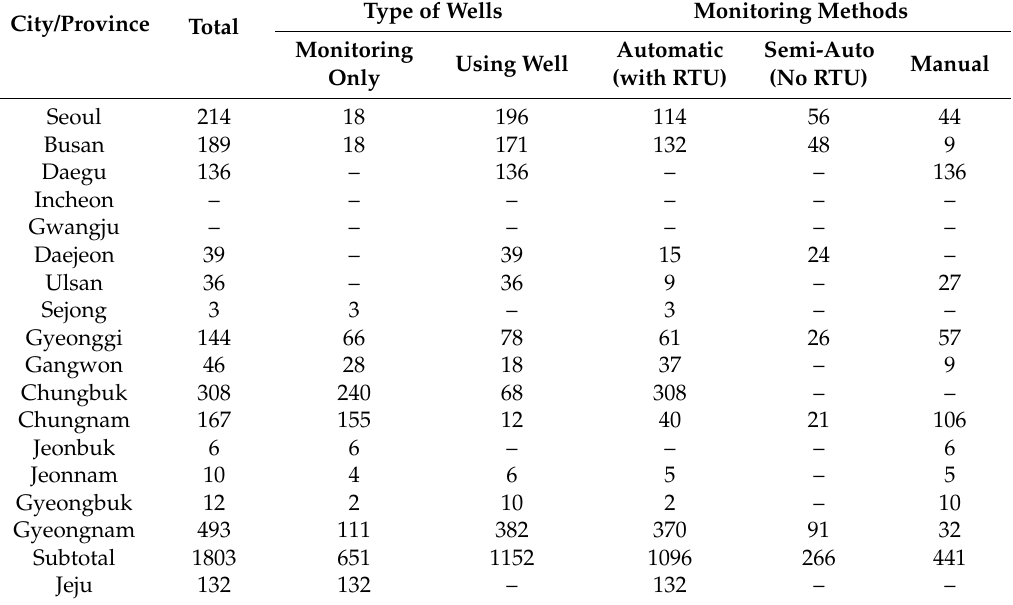
Table 4. Current status of subsidiary/local groundwater monitoring wells in Korea [42]. RTU = remote terminal